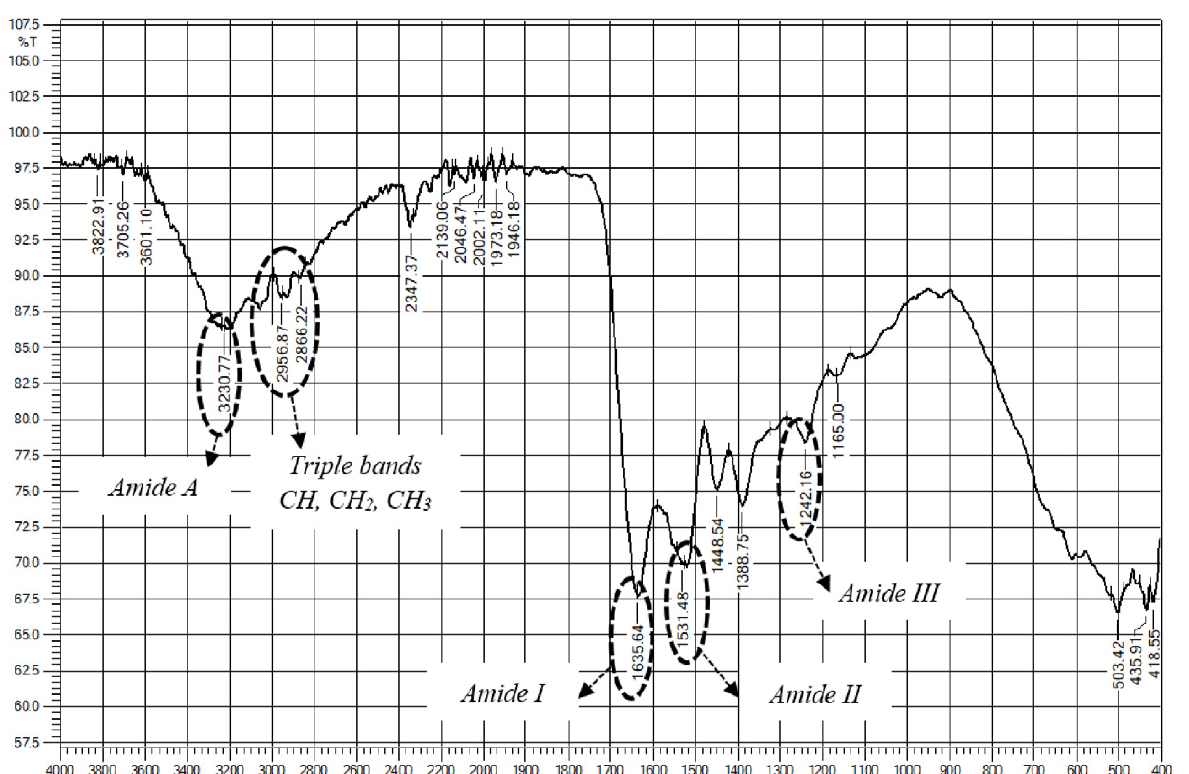
Figure 2. FTIR spectrum of keratin isolated from waste wool with SubCW at temperature of 180 °C and a reaction time of 60 min.